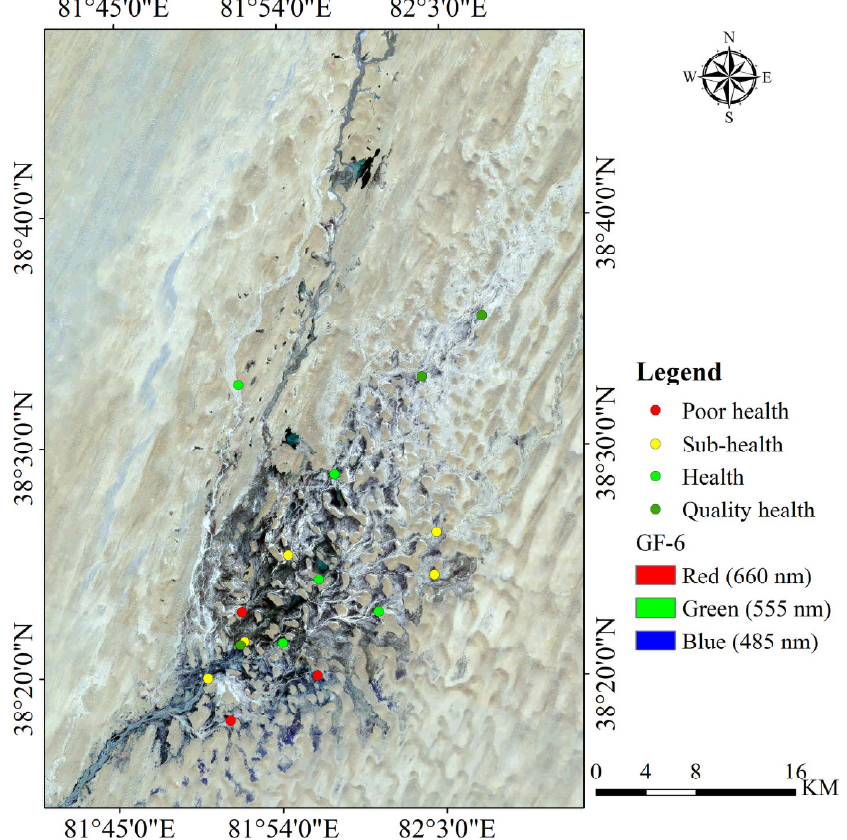
Figure 5. Spatial distribution map of PeITC health degree.